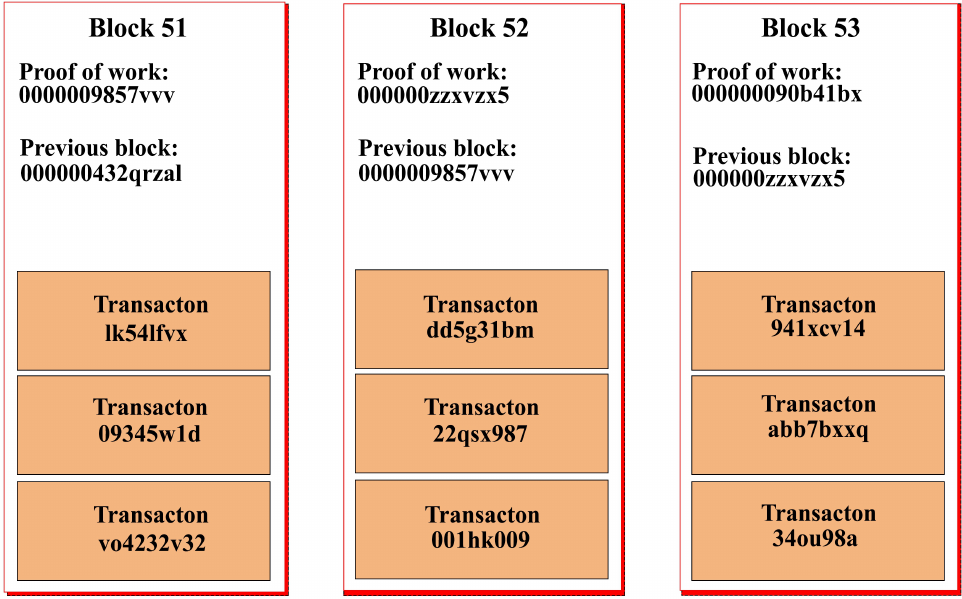
Figure 4. Parent–child relationship among blocks in